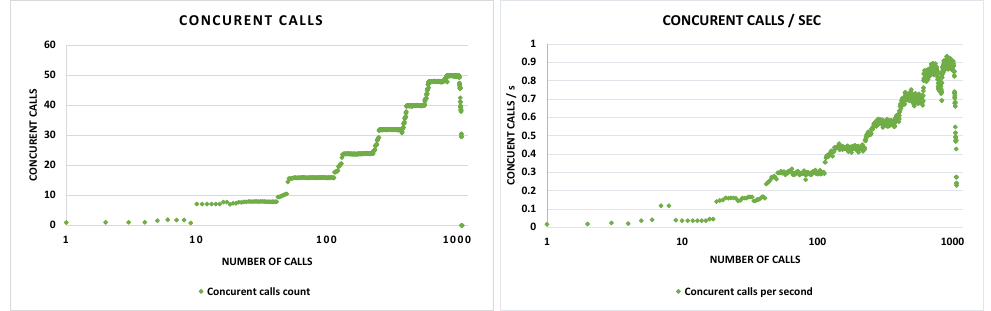
Figure 7. Concurrent calls evaluation: evolution of concurrent calls in 20.12 min ( left ), and evolution of concurrent calls per second ( right